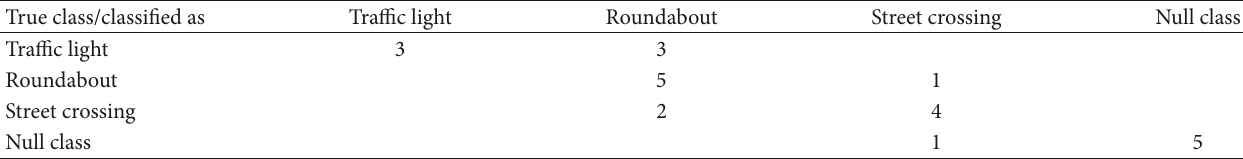
Table 6: Confusion matrix using the SVM with a Gaussian Kernel classifier.